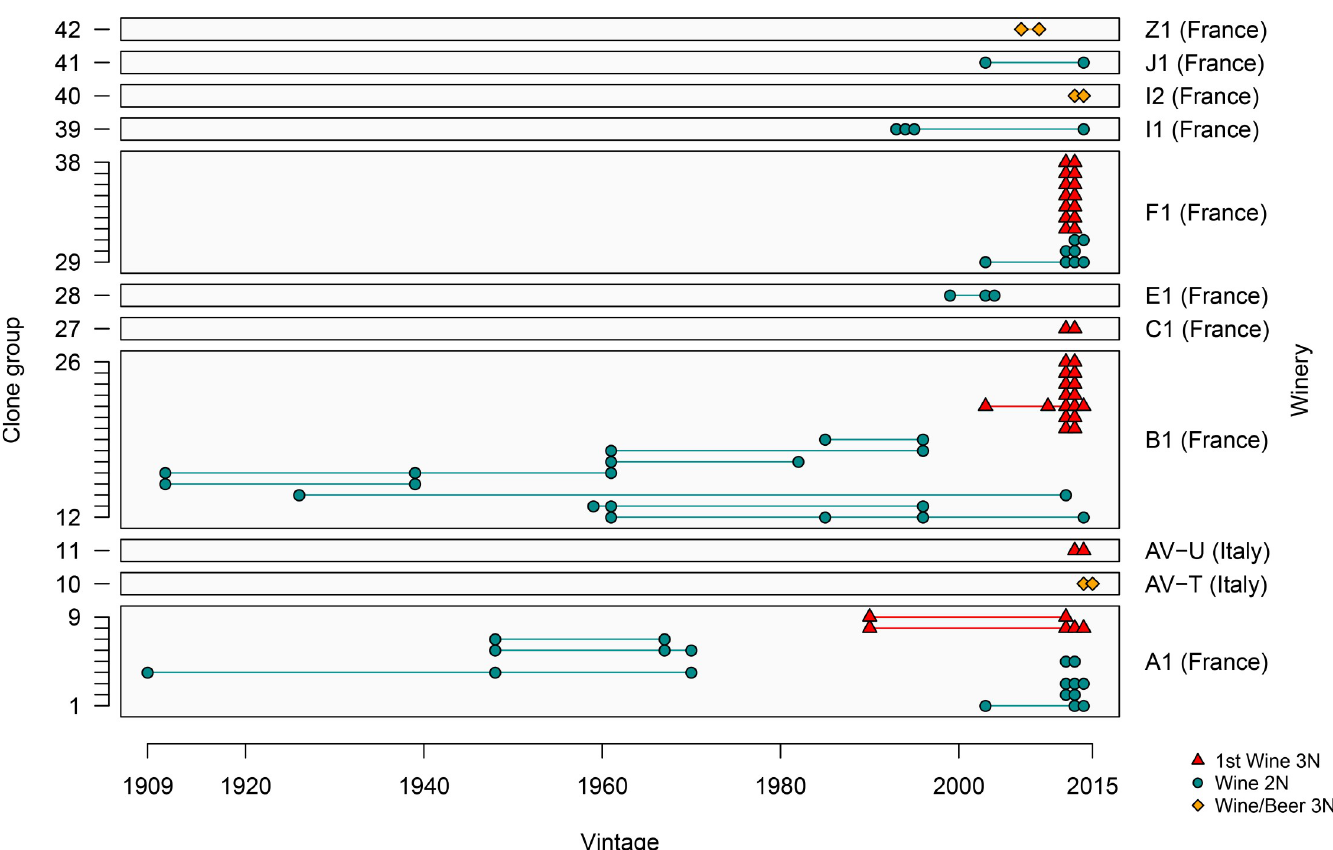
Fig 4. Identification of clone groups within the same winery over different vintages. Genetically identical isolates were designed as clone group. 42 groups gathering clones isolated from the same winery over different vintages were identified, corresponding to 11 wineries from France and